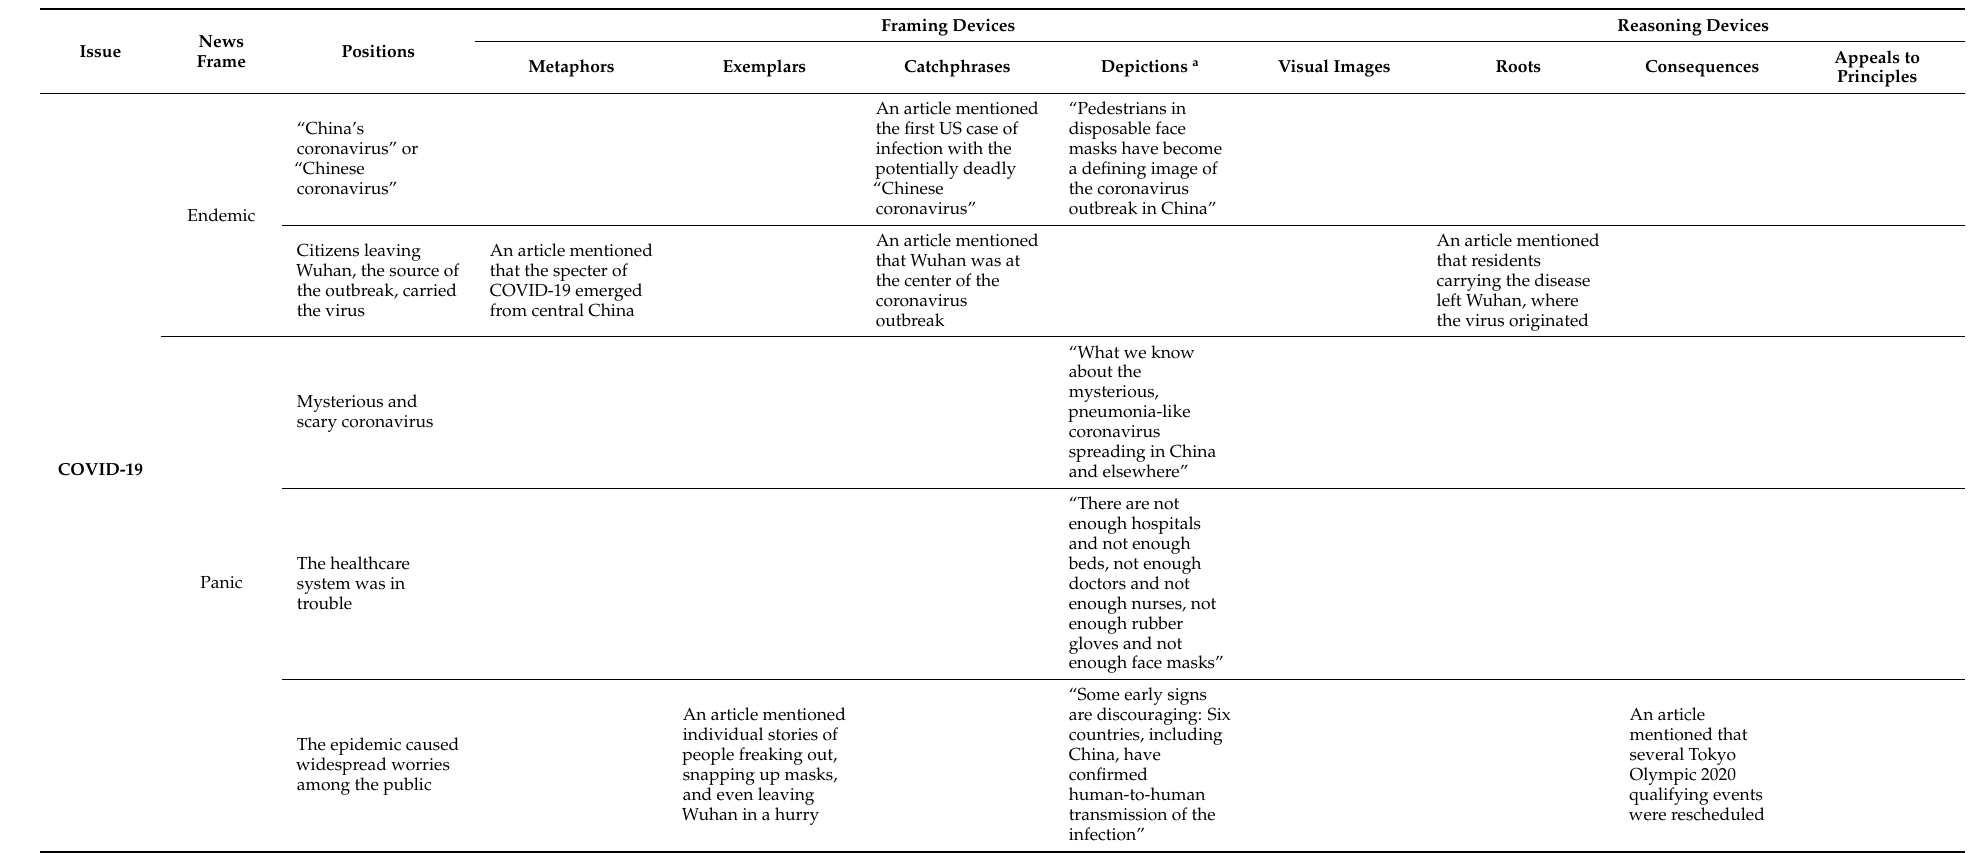
Table 2. Framing analysis of monkeypox and COVID-19